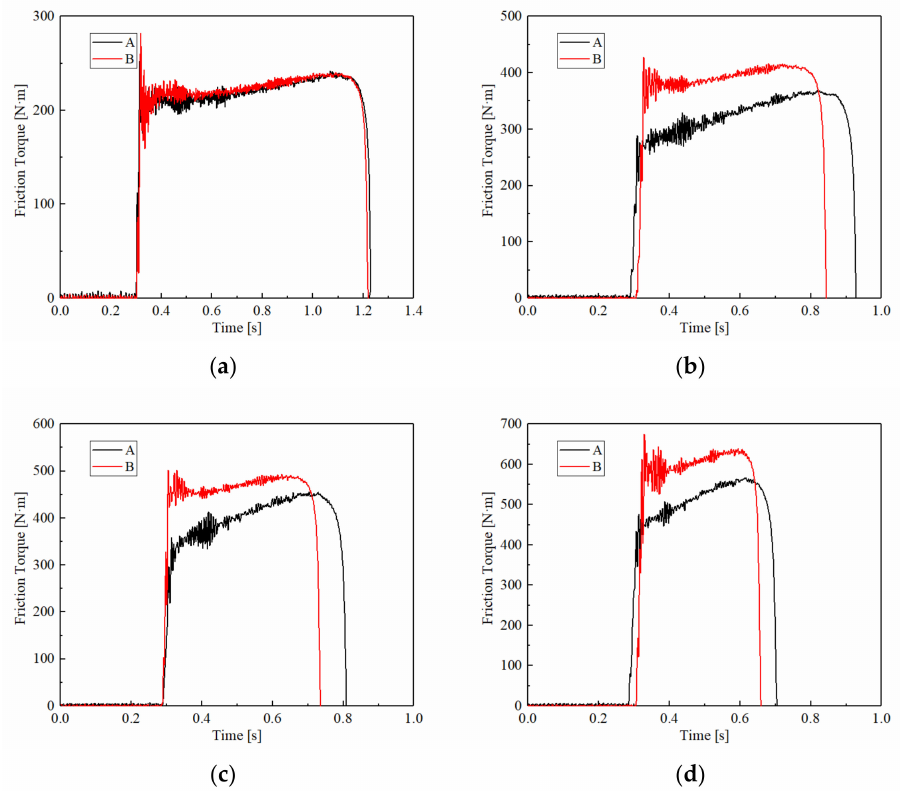
Figure 6. Variations of the friction torque at different applied pressures. ( a ) 1 MPa; ( b ) 1.5 MPa; ( c ) 2 MPa; ( d ) 2.5